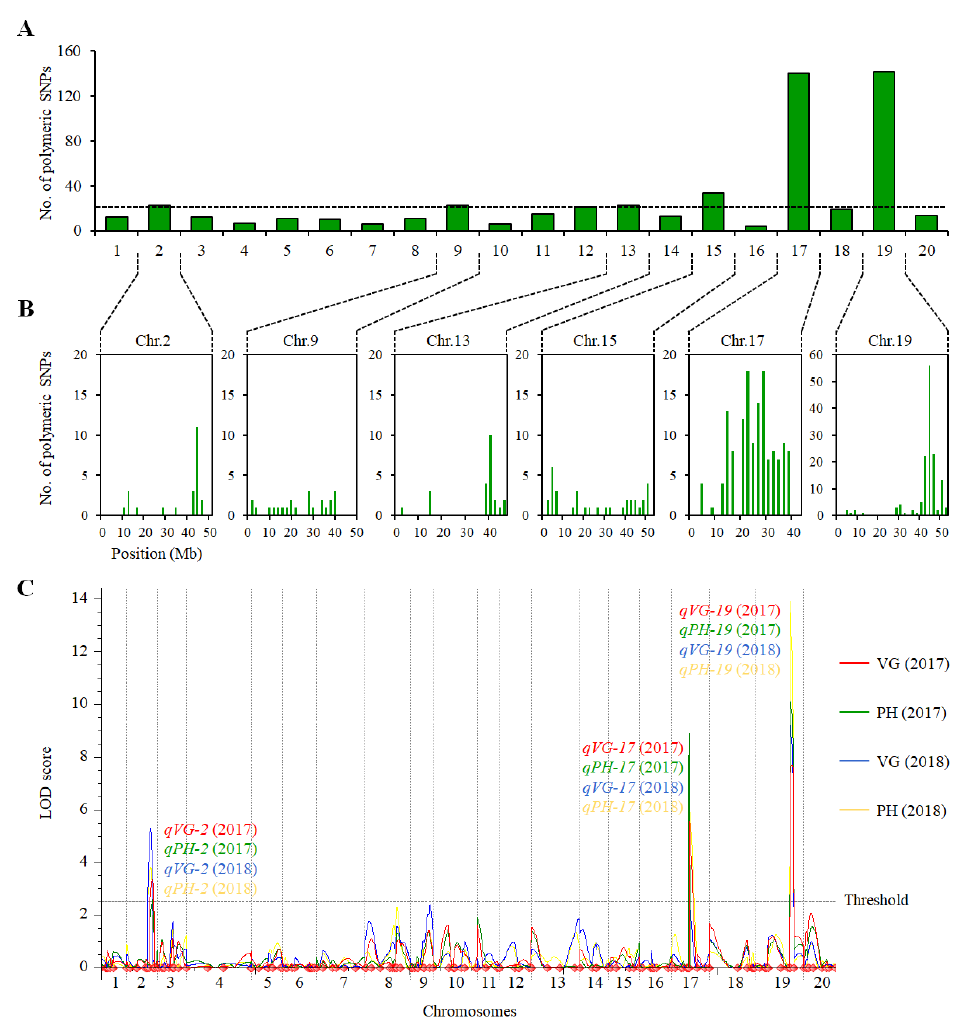
Figure 2. Number of polymorphic SNPs and QTL mapping in the RIL population from the ZH39 × NY27-38 cross. ( A ) The number of polymorphic SNPs between two DNA bulks, EB2 and VB2, on all chromosomes. The dotted line is the threshold to identify putative QTLs. ( B ) Six putative regions for QTLs associated with VG and PH. Each bar represents the number of polymorphic SNPs between EB2 and VB2 in a 2 Mb region. ( C ) QTL mapping of VG (red for 2017 and blue for 2018) and PH (green for 2017 and yellow for 2018) in the ZH39 × NY27-38 RIL population; the threshold (dotted line) of LOD values was 2.5.